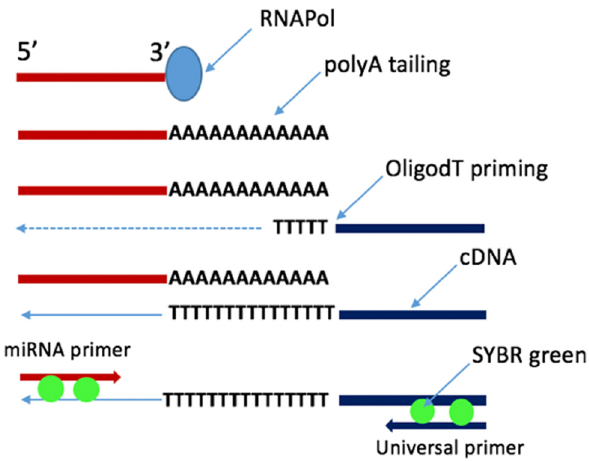
Figure 2: PCR - based miRNA quanti fi cation. This synthesizes a fi rst stand cDNA from an RNA sample which is then ampli fi ed and quanti fi ed by qPCR using an miRNA - speci fi c